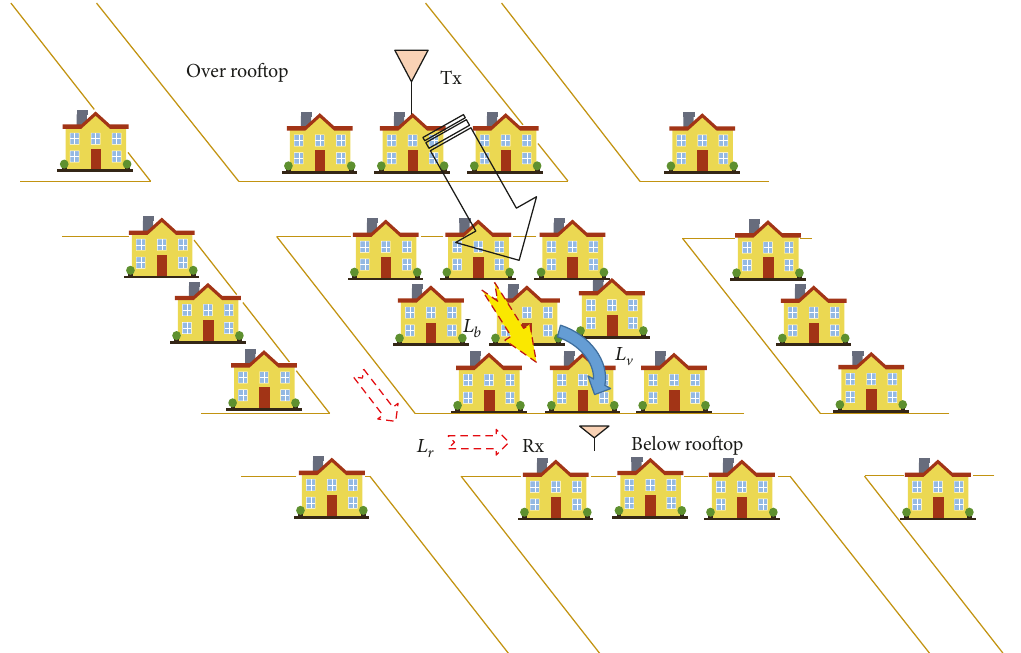
Figure 6: A case that houses are separated together in the over rooftop environment.